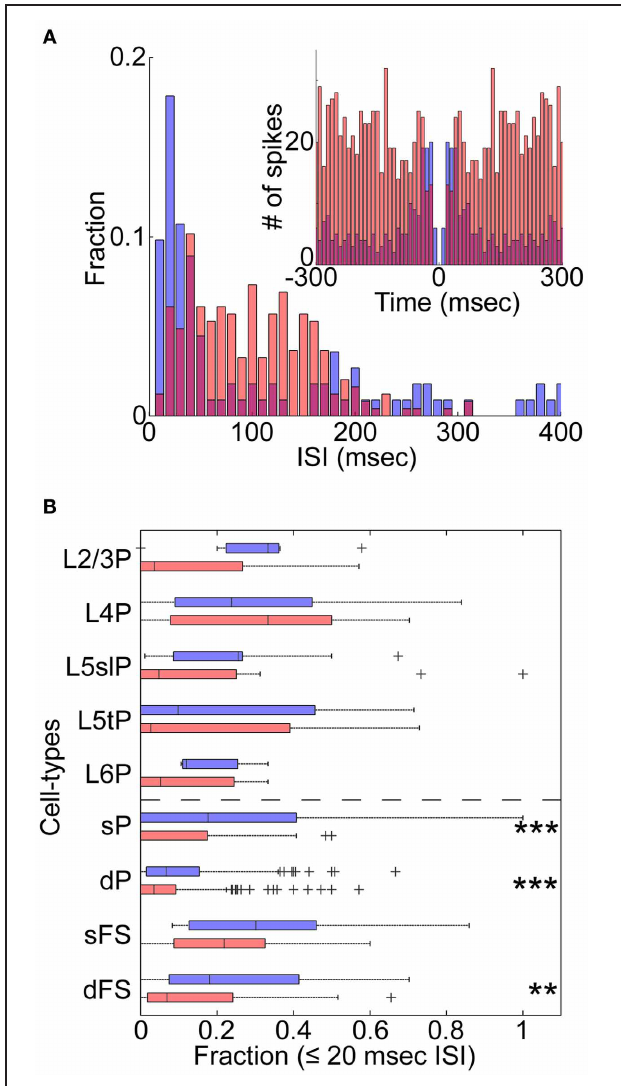
FIGURE 3 | State-dependent burst firing. (A) An example of the distribution of inter-spike intervals (ISIs) for a morphologically identified L5tPC (see also Figure 2B ) during the synchronized (blue) and desynchronized states (red). Inset: auto-correlogram. (B) Fraction of burst-like firing ( ≤ 20ms ISIs) across cell-types during the synchronized (blue) and desynchronized states (red). ∗∗ p < 0 . 005 and ∗∗∗ p < 0 . 0005 (Kruskal–Wallis test with post-hoc rank sum